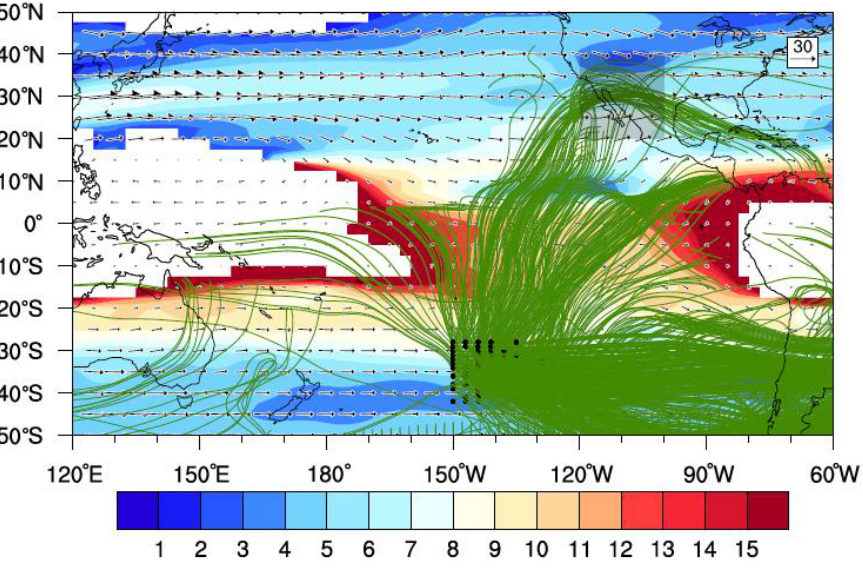
Figure 7. The Rossby wave ray trajectories ( green lines ) starting from the southern Pacific region ( black dots ). The shading and the vectors indicate the climatological stationary total wavenumber and wind in winter at 300 hPa. The gray box indicates the location of the NAM region.